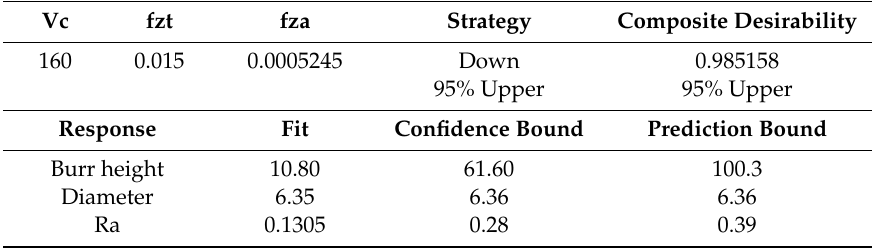
Table 14. Response optimization